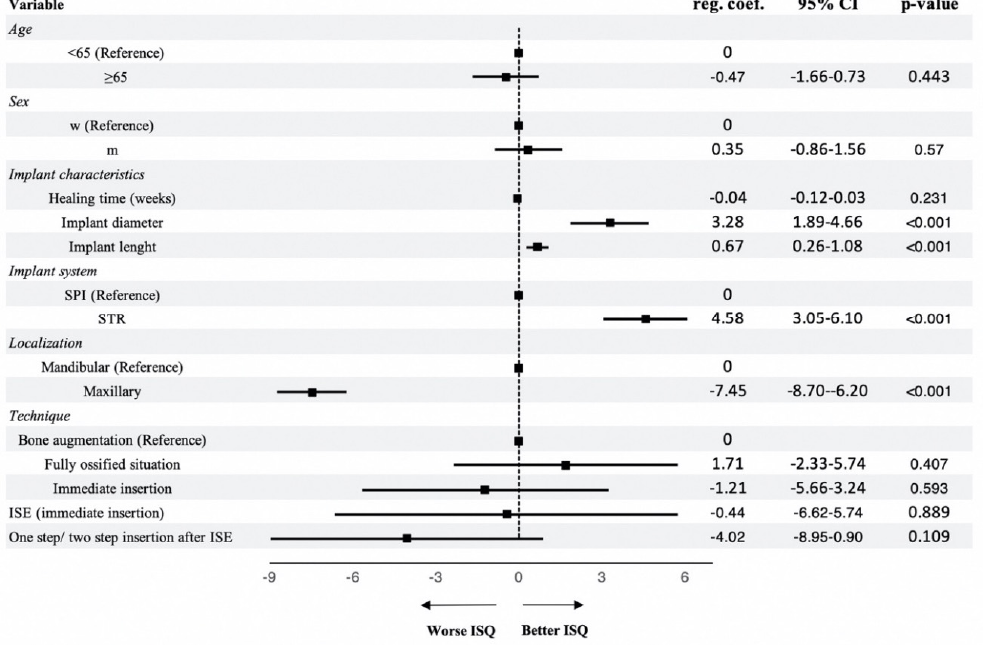
Figure 4. Regression model of factors influencing primary implant stability. STR: Straumann implants. SPI: Thommen implants. ISE: Internal sinus elevation. Reg. coeff.: regression coefficient. 95% CI: 95% confidence interval.